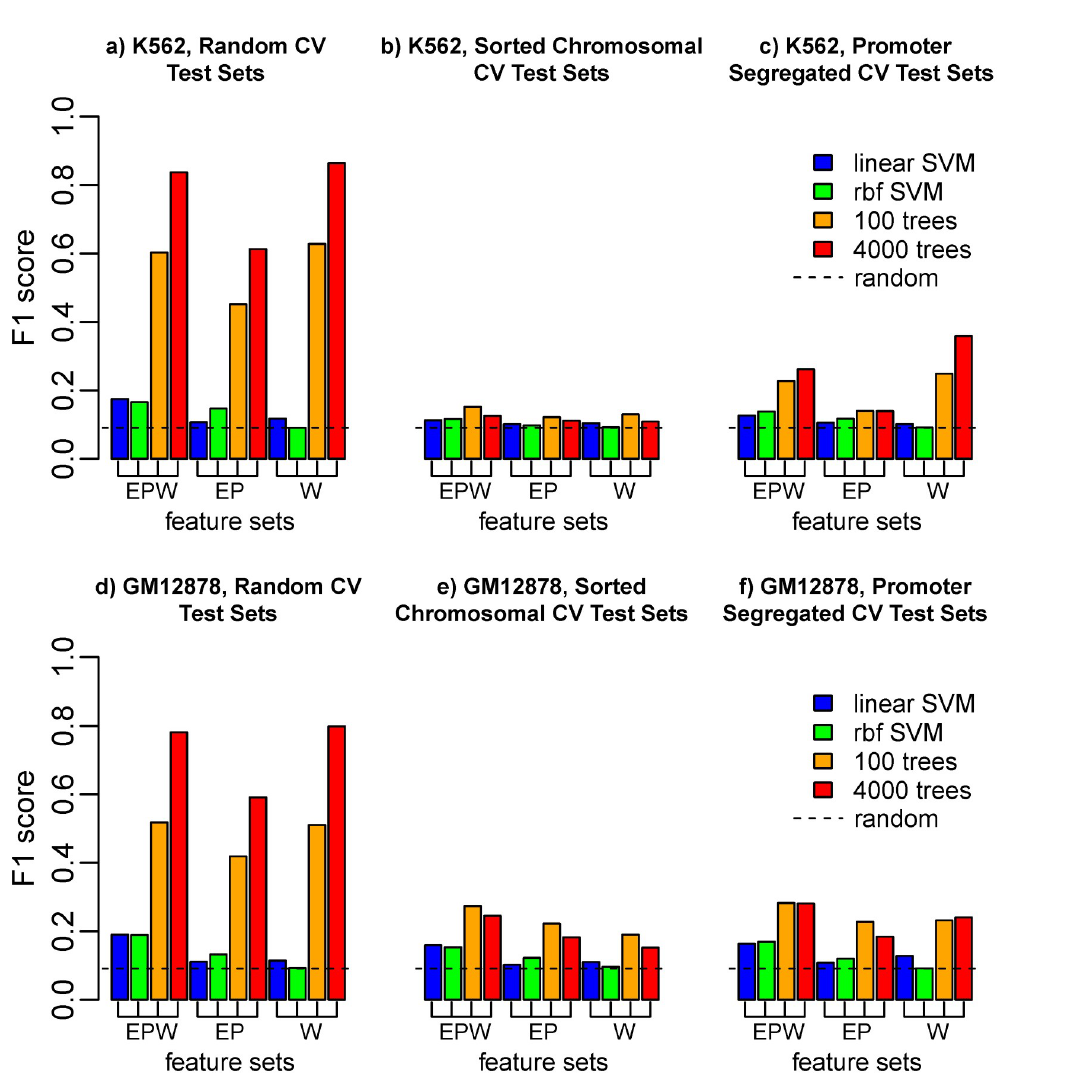
Fig 2. The apparently high predictive power of epigenetic state to identify enhancer-promoter (EP) interactions is largely due to incorrect evaluation of generalization performance. a) For cell line K562, using training data from Ref. 1, with random assignment of positive and negative EP pairs to cross-fold validation (CV) test sets, a gradient boosting classifier with a very large number of trees (4000) is able to achieve F1 > 0.8 with EPW or W features. b) If EP pairs with shared epigenomic features are properly forced to be in the same CV test set by sorting by chromosomal position, the predictive power is only slightly better than random, F1 = 1/11. c) If EP pairs sharing the same promoter are forced to be the same test sets, test set contamination through EP features is eliminated, but some can still occur through shared window features (W). d,e,f) A similar reduction in performance is observed when removing test set contamination in cell line GM12878 with sorted chromosomal CV test